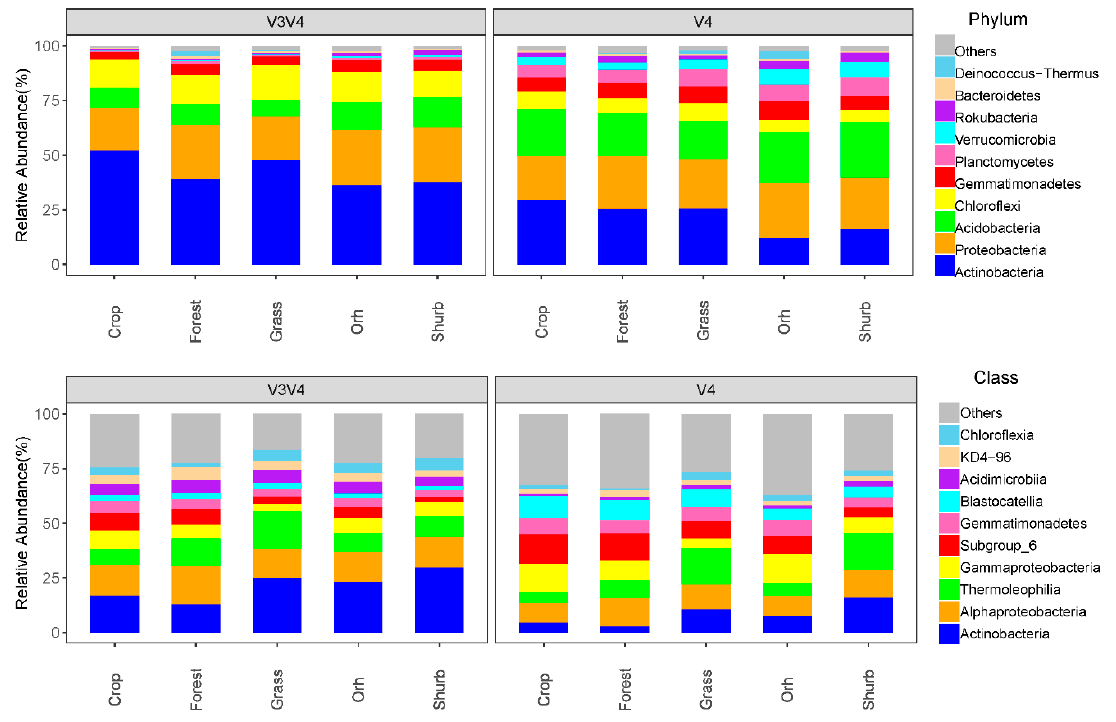
Figure 2. The community compositions of soil bacteria in different land uses on the Loess Plateau. The top panel represents the distributions of the soil bacterial community at the phylum level; the bottom panel represents the distributions of the soil bacterial community at the class level. Orh refers to orchards. Primer pair 520f/802r targeted the V4 region of the 16S rRNA gene; primer pair 338f/806r targeted the V3–V4 region of the 16S rRNA gene.